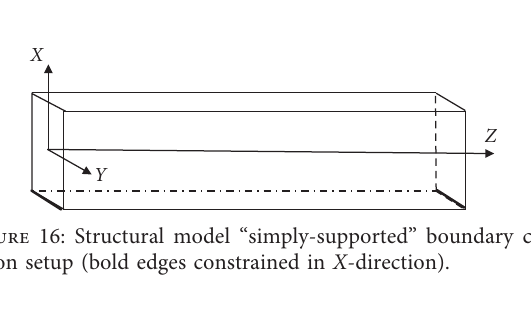
Figure 15: Flowchart detailing flow of data for the weakly coupled thermomechanical analysis.